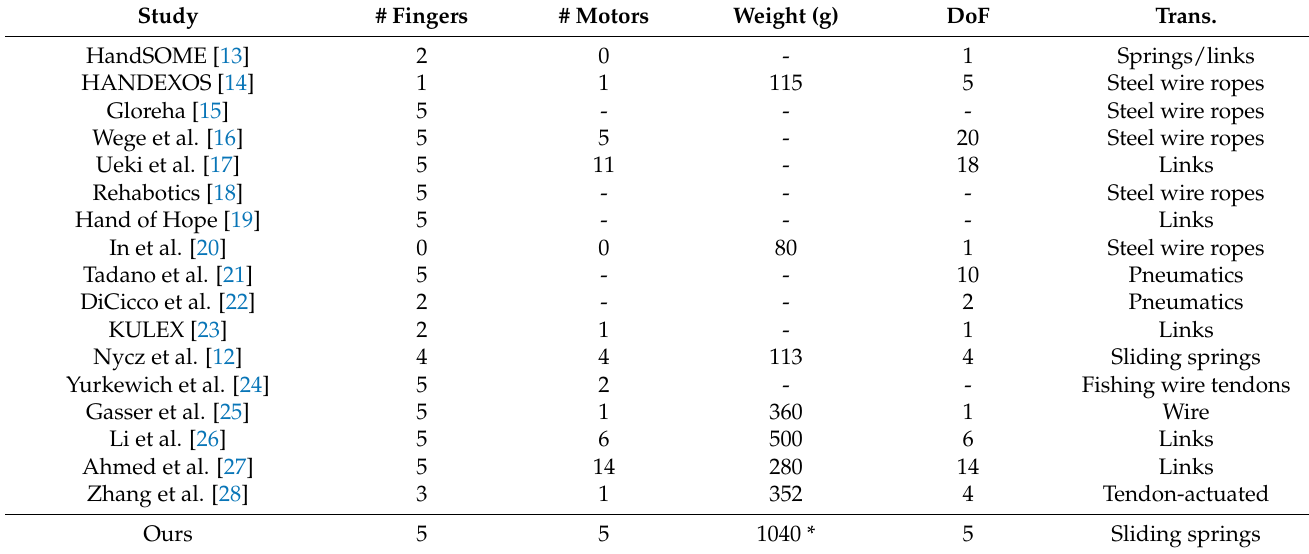
Table 1. Comparison of state-of-the-art hand exoskeletons. #: number of DoF, degree of freedom; Trans., transmission mechanism. *: the weight of the complete system includes the hand exoskeleton, hand-sensing glove, linear motors, and